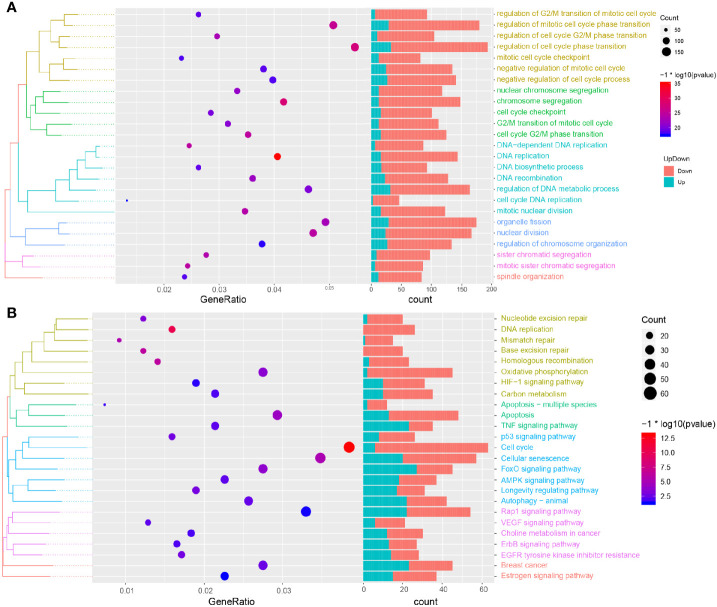
Functional enrichment analysis and GSEA analysis. (A) Biological processes involved in resveratrol affected genes. (B) KEGG pathways involved in resveratrol affected genes.